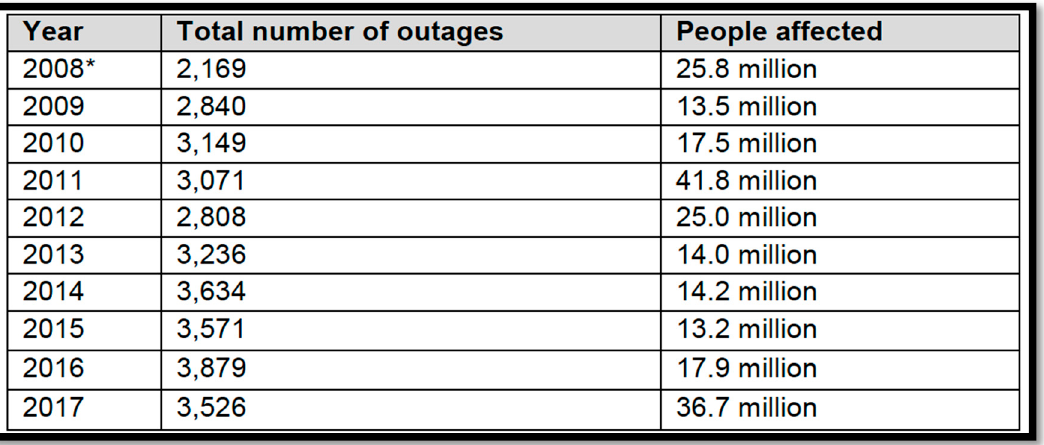
Figure 1. U.S. reported power outages by year. Source: Eaton’s Blackout Tracker [16].